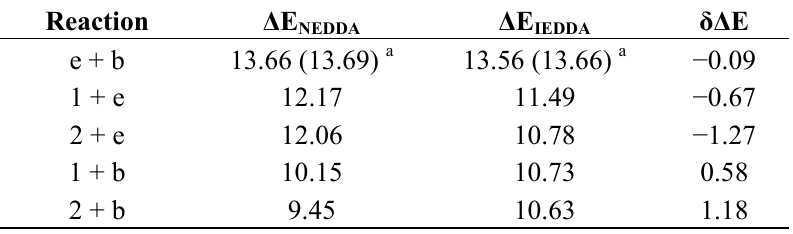
Table 2. HOMO-LUMO gaps, in eV, for the NEDDA and IEDDA reactions of fragments 1 and 2 with ethylene and 1,3-butadiene. Δ E = E − E and NEDDA LUMOdienophile HOMOdiene Δ E = E − E . Also, δ Δ E = Δ E − Δ E . Results for reaction IEDDA LUMOdiene HOMOdienopile IEDDA NEDDA e + b are also